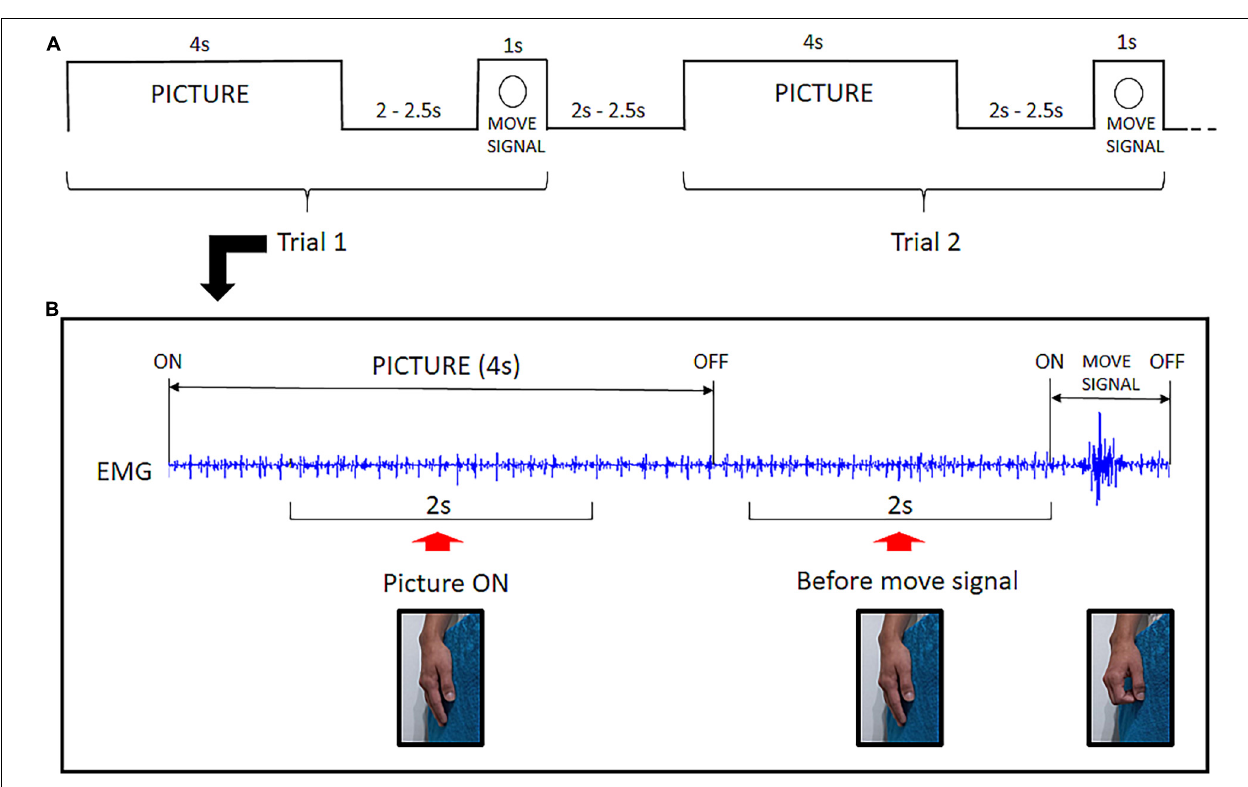
FIGURE 2 | Experimental Design: (A) Example of the temporal structure of two consecutive trials. Each picture was presented for 4 s followed by an interval varying from 2.0 to 2.5 s. Then the move signal appeared (annulus) setting off the flexion of fingers. After a 2.0 to 2.5 s interval, a new trial began. (B) Raw EMG signal excerpted from a single trial illustrating the two time-windows for EMG analysis. The Picture ON context was investigated throughout a 2 s EMG segment during picture exposure. The before move signal context refers to a 2 s EMG segment preceding the task signal for fingers flexion. No overt hand movement is present before the move